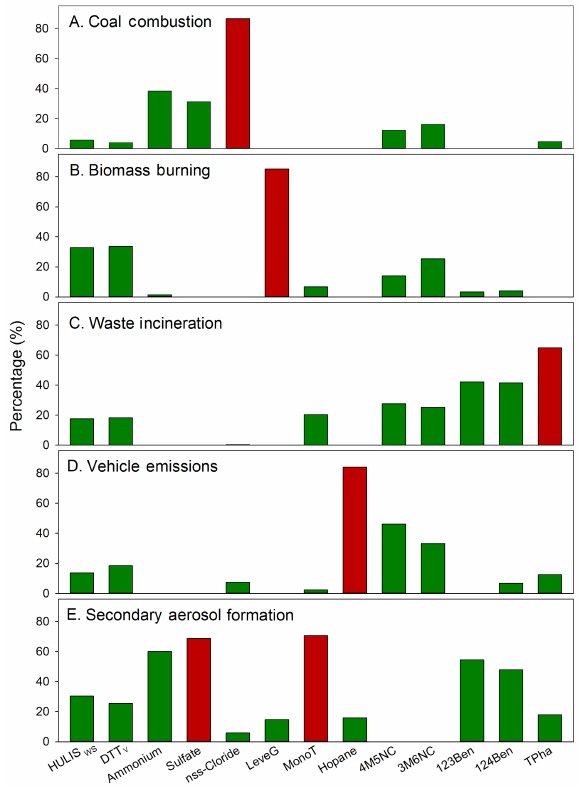
Figure 3. Distribution of HULIS WS , HULIS WS -associated DTT activity and other measured species in the five sources resolved by PMF. Columns in dark red indicate characteristic tracers of each